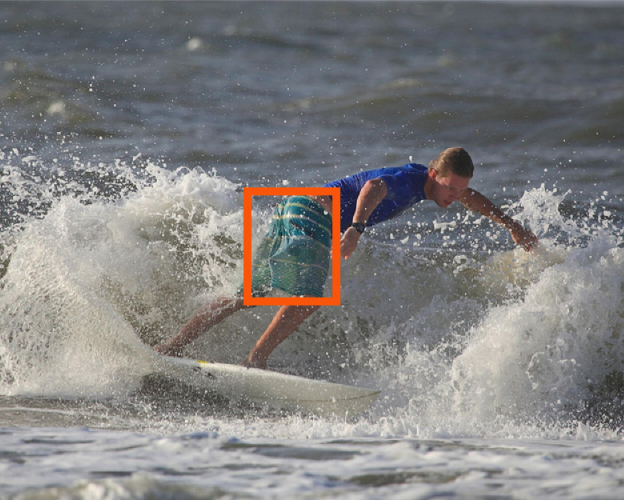
Figure 2. Example question-image pair from the VQAv1 dataset [3]. The red bounding box indicates the question-critical